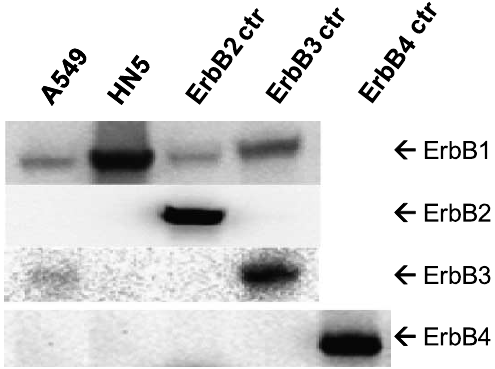
Fig. 3. ErbB expression profile in two ErbB1-overexpressing human tumor cell lines. Lysates of HN5 and A549 cells were subjected to SDS-PAGE electrophoresis followed by immunoblotting using anti- bodies against ErbB1–4. Lysates of cells expressing high amounts of individual ErbB receptors were used as positive controls (ErbB2 pos- itive control: SKBR3 cells; ErbB3 positive control: MDA-MB-231 cells; ErbB4 positive control: HEK293 cells transfected with ErbB4